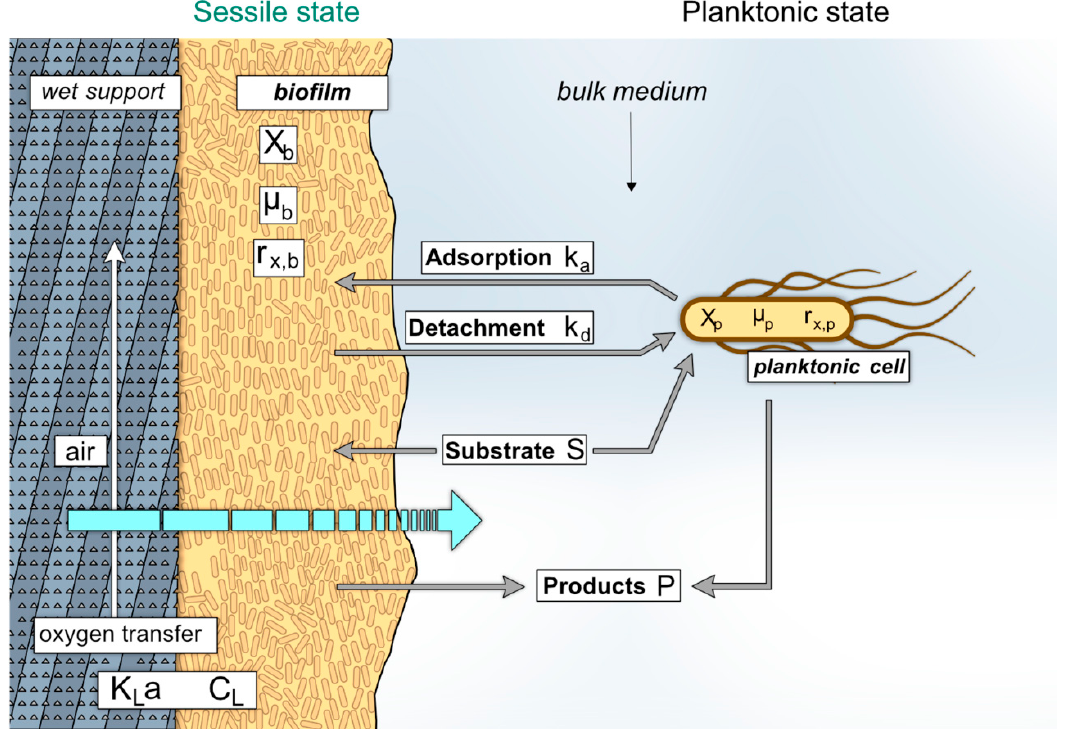
Figure 2. Schematic description of the growth model developed for the two-compartment trickle-bed biofilm reactor. The transition of the cells between the two compartments from the sessile (1) and planktonic (2) state and vice versa takes place in the packing tower (see Figure 1 for a scheme of the cultivation set-up). The scheme shows an enlarged view of a support element inserted in the packing tower and describes the parameters that were used to build the growth model (see Table 2 for a detailed description).